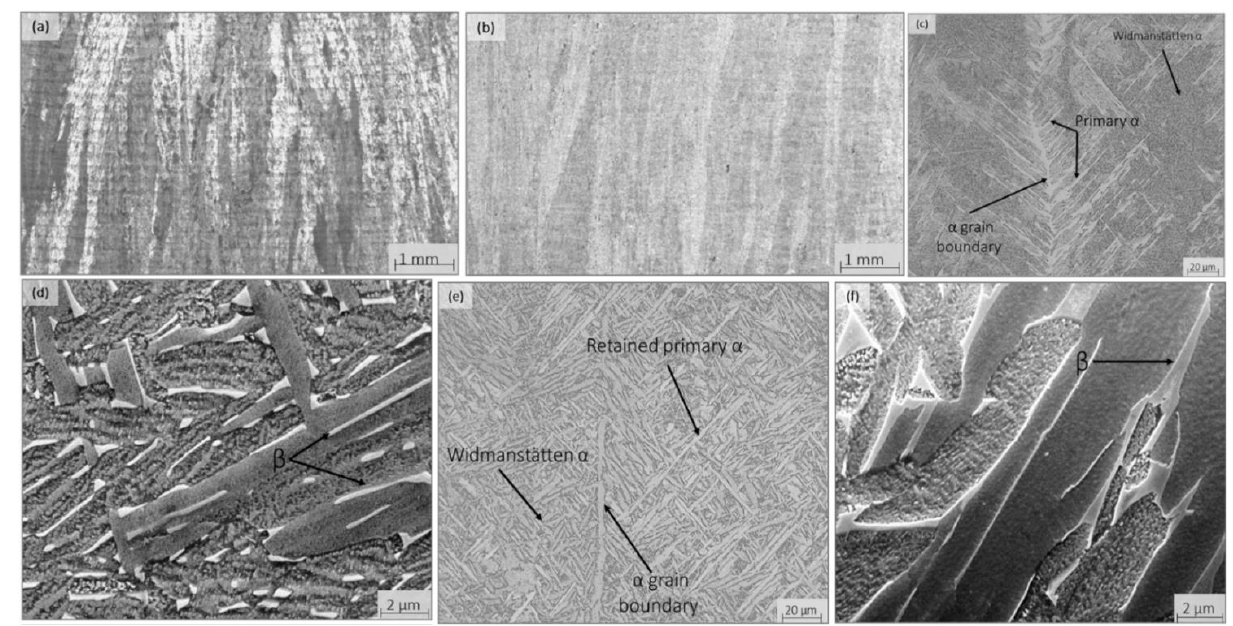
Figure 25. Ti6Al4V EBM printing ( a ) as-built macrostructure, ( b ) macrostructure after HIP, ( c , d ) as- built microstructure, and ( e , f ) HIP microstructure [128]; with permission from Elsevier.